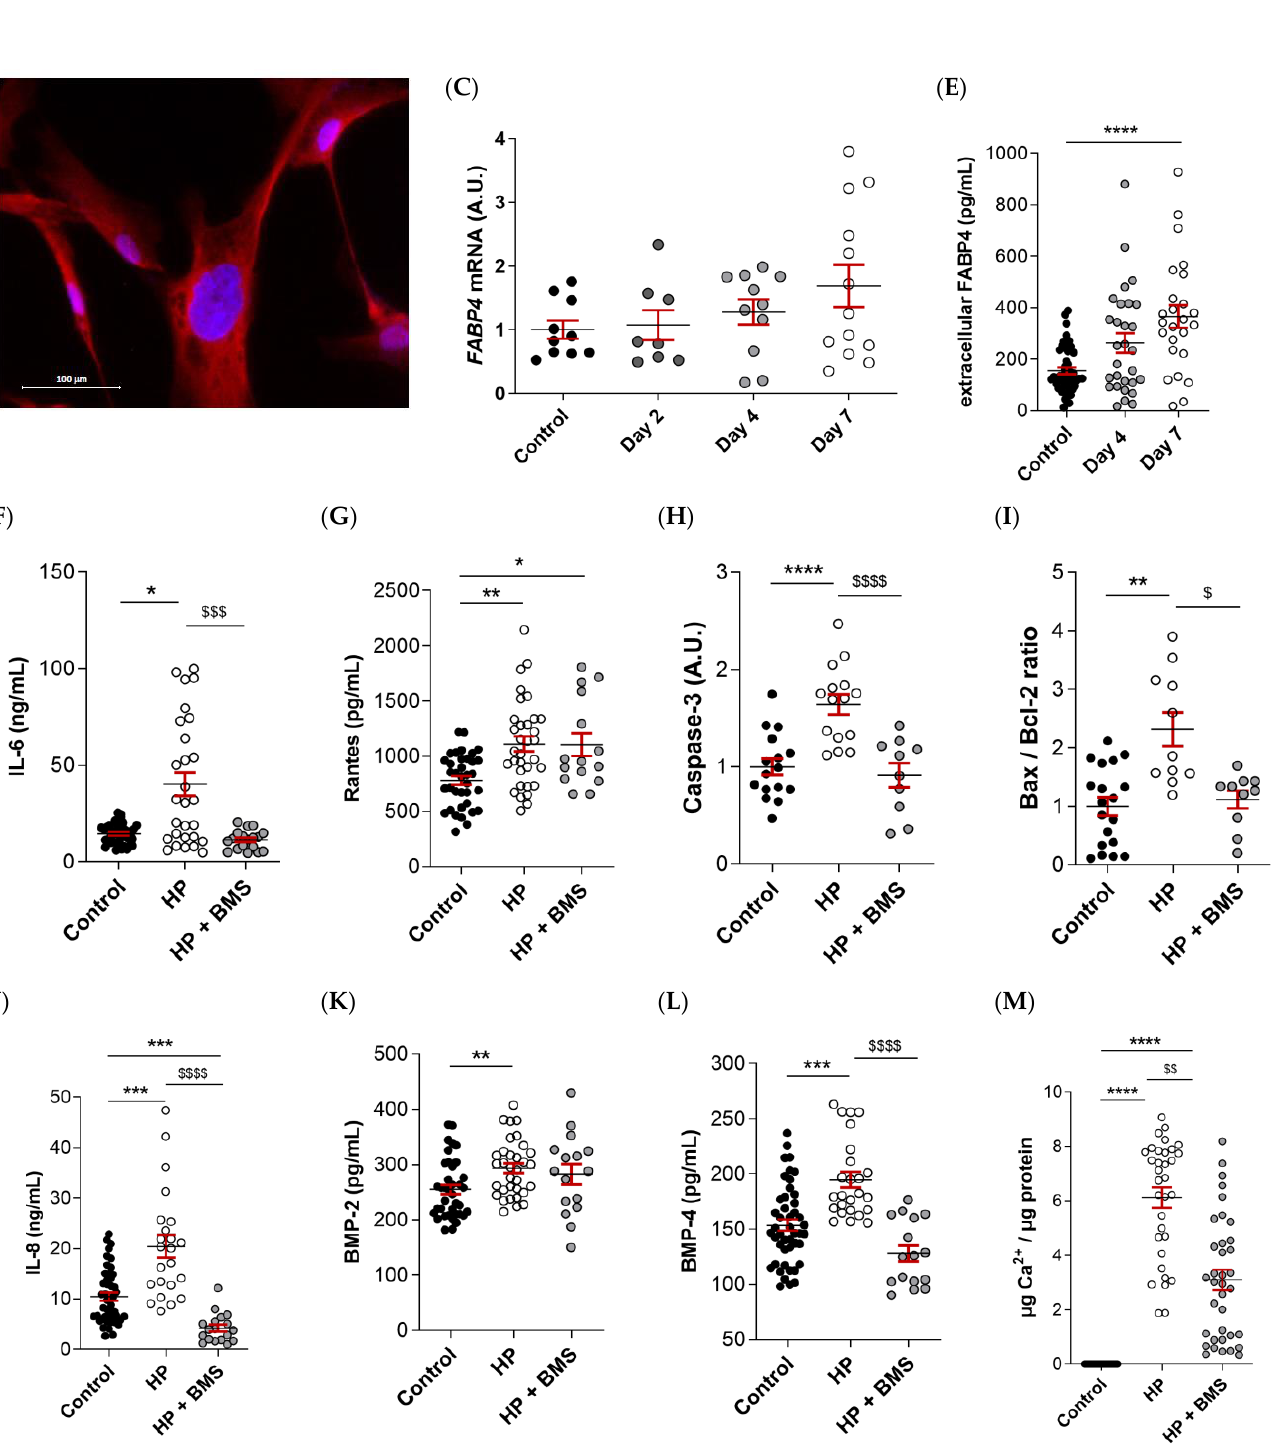
Figure 4. The FABP4 expression in the cultured VICs from AV of AS patients. ( A ) Representative microphotographs of immunofluorescence of FABP4 (red) counter-stained with DAPI (blue) in VICs derived from the AV of men and women. Time-course mRNA expression of FABP4 in ( B ) male and ( C ) female VICs cultured in osteogenic media at days 2, 4, and 7. ( D ) Intracellular and ( E ) extracel- lular protein levels of FABP4 in male VICs cultured in osteogenic media at day 7. Protein levels of inflammatory markers ( F ) IL-6 and ( G ) Rantes and the osteogenic markers ( J ) IL-8, ( K ) BMP-2, and ( L ) BMP-4 in male VICs ’ supernatant cultured in osteogenic media with or without BMS at day 7. Protein levels of pro-apoptotic marker ( H ) caspase-3 and the ( I ) Bax/Bcl-2 ratio in male VICs ’ cell extract cultured in osteogenic media with or without BMS at day 7. ( M ) The calcium content in the male VICs ’ cell extract cultured in osteogenic media with or without BMS at day 7. Dot plots repre- sent the mean and standard error of the mean (SEM) of each group of subjects (men N = 3 and